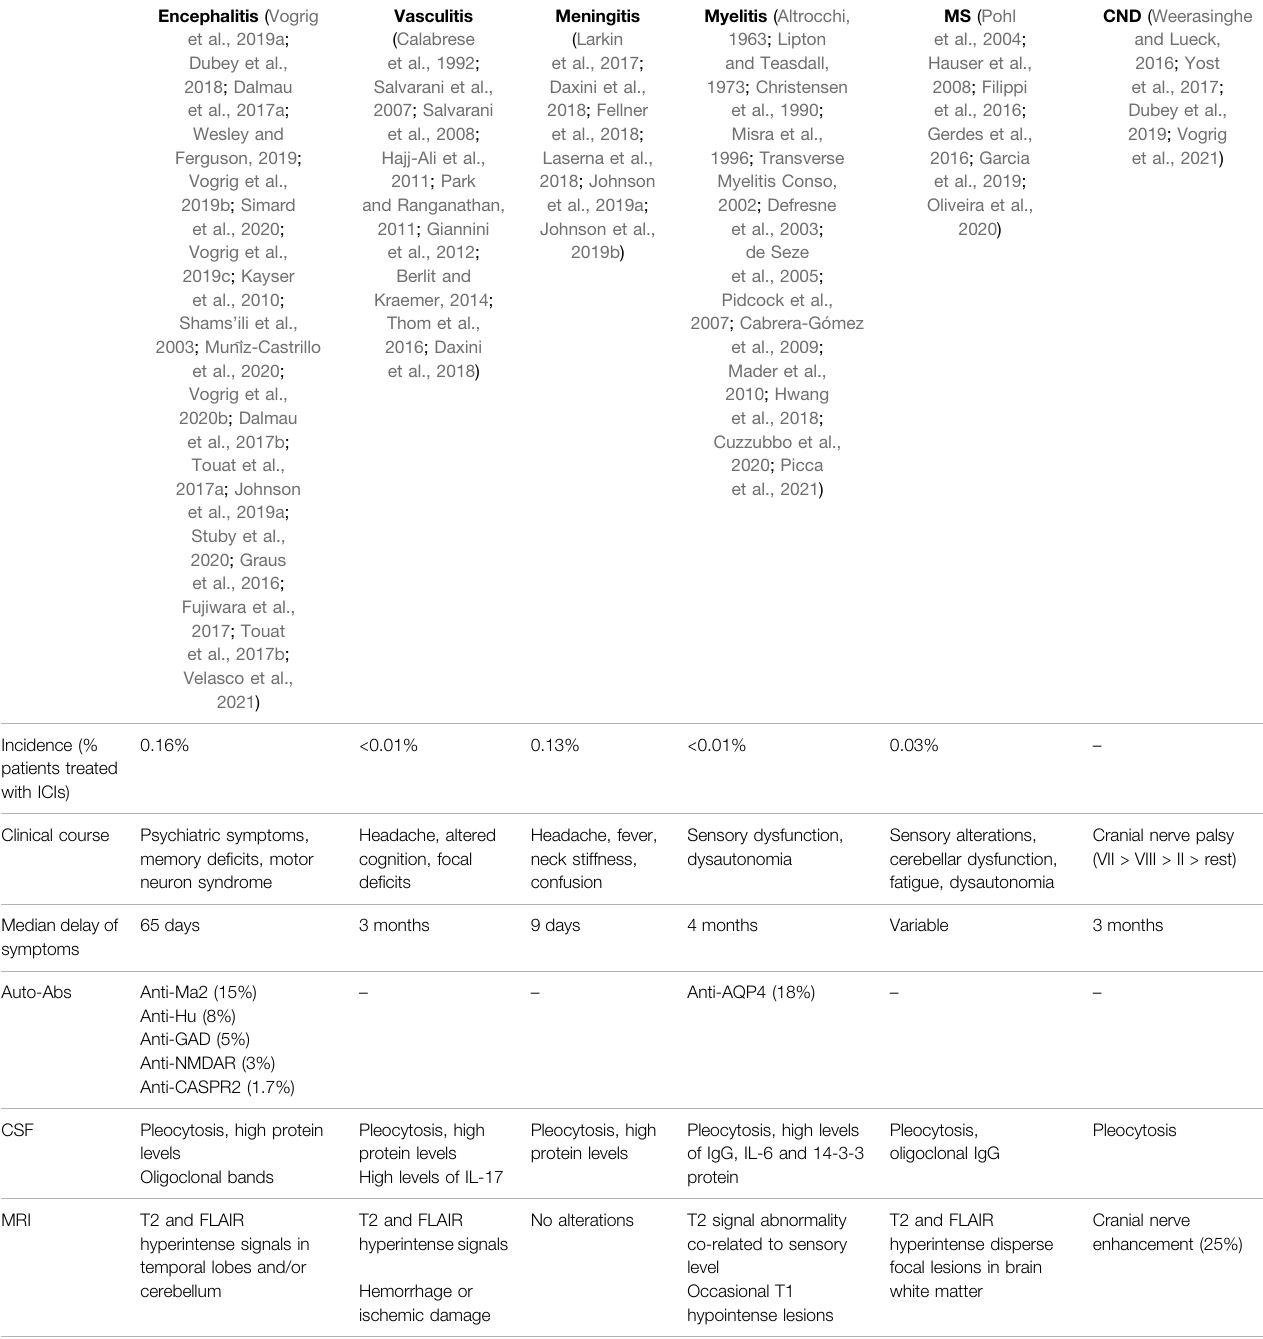
TABLE 2 | Clinical presentation of the main ICI-related central neurological syndromes